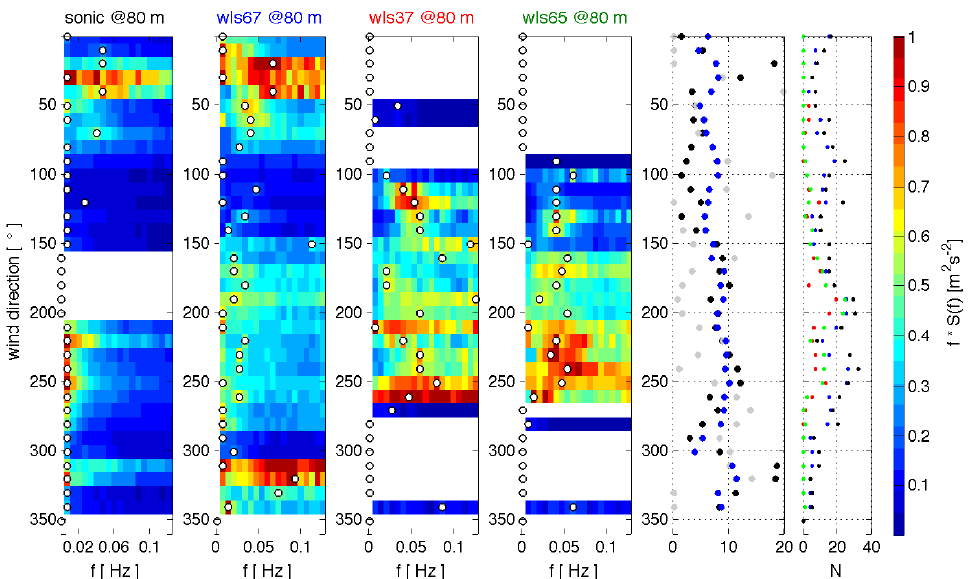
Figure 14. Composites of hourly energy spectra of u at 80m for all wind direction bins from wls67, wls37 and wls65 (from left to right) filtered for unstable wind conditions. White circles indicate the maximal spectral energy density of each direction bin. Additional subplots show wind direction bin averaged horizontal wind speeds at 108m (blue in (m · s − 1 )), power output (black in (MW/100)) and blade pitch angle (gray in ( ◦ )) of wind turbine WT6 and the number of averaged hours in each bin for wls67 (blue), wls37 (red) and wls65